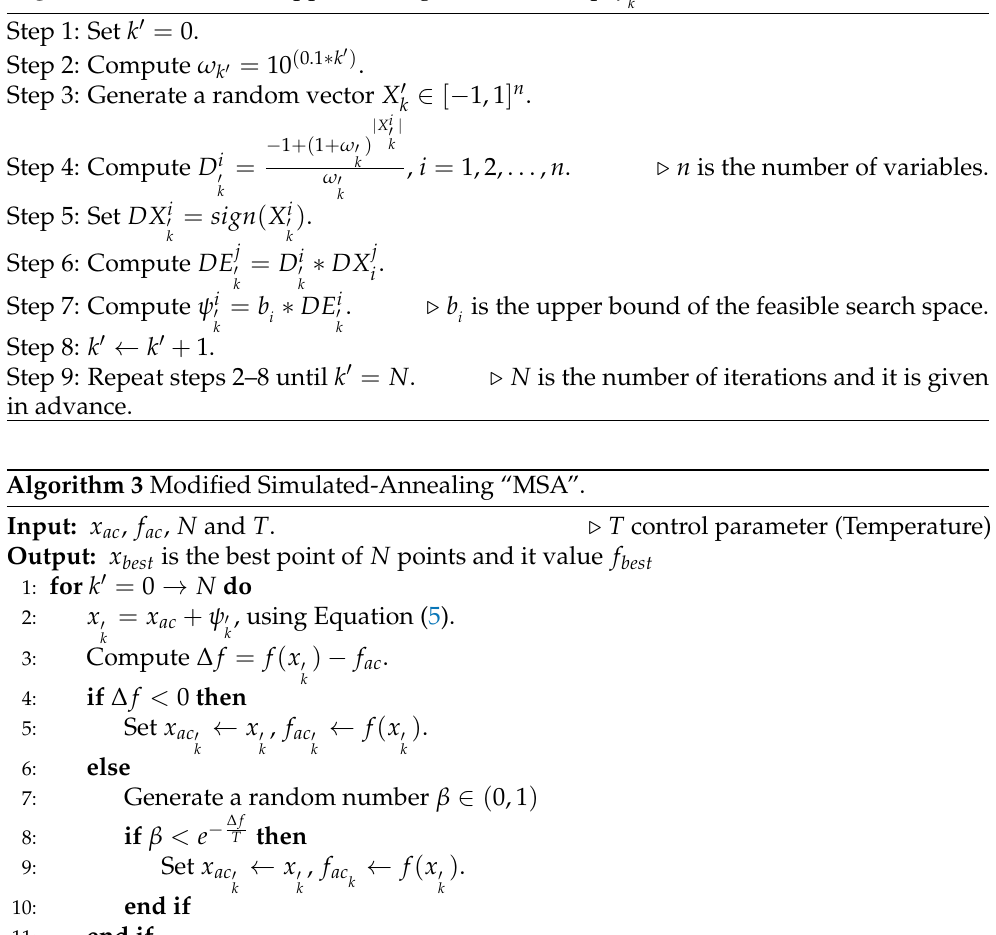
Algorithm 2 The second approach to generate the step ψ (cid:48)